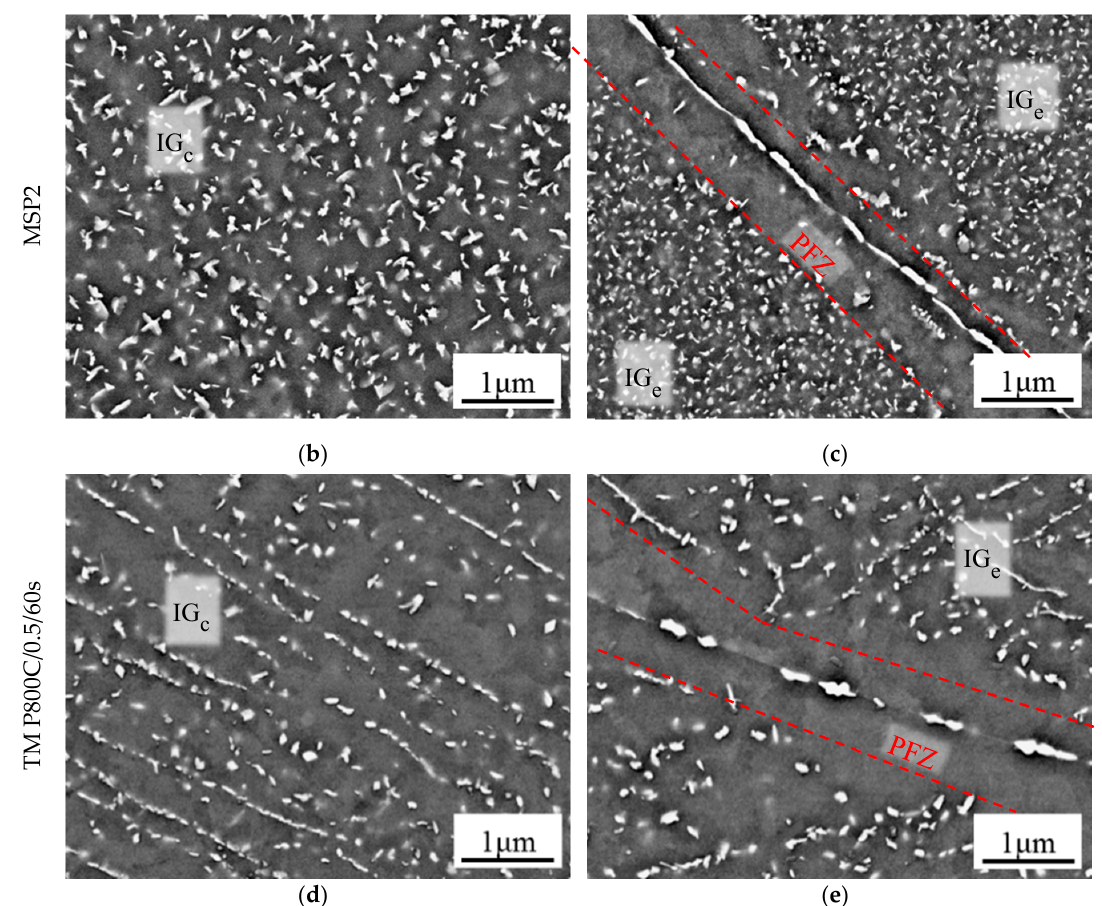
Figure 4. Schematic drawing of precipitate microstructure ( a ). SEM micrographs of 17Cr5 steel: Precipitate morphology in the grain interiors (IG c ) after MSP2 ( b ) and TMP800C/0.5/60s ( d ) and intragranular particle morphology in exterior areas (IG e ) close to PFZs in MSP2 ( c ) and TMP800C/0.5/60s ( e ) materials.